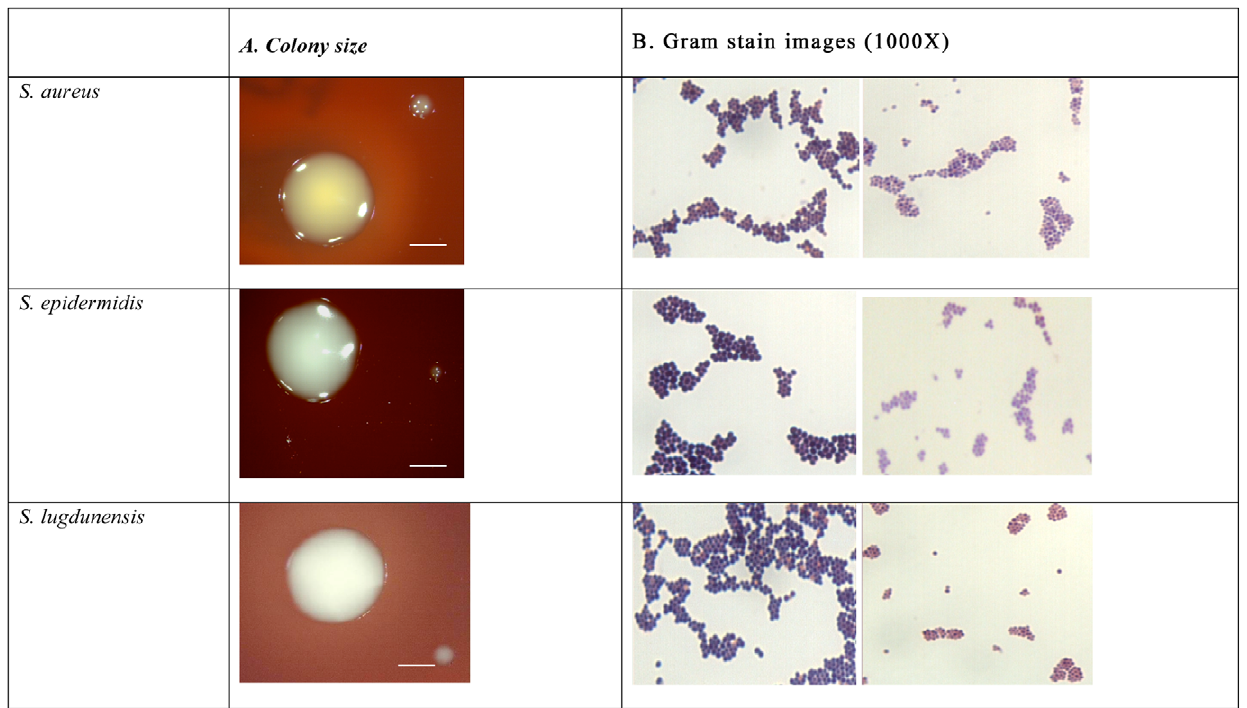
Figure 2. Morphological variations in size, pigmentation, haemolysis and Gram stain between WT and their corresponding SCVs in S.aureus , S.epidermidis and S.lugdunensis . Column (A) shows differences in size and pigmentation between WT colonies (left) being larger and more pigmented than their SCVs (right) which are minute with diminished pigmentation (scale bar represents 1 mm). Column (B) shows the differences in response to Gram staining with WT cells (left) staining significantly darker than their corresponding SCVs